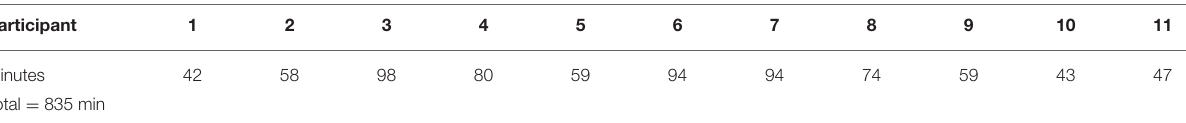
TABLE 3 | Duration of the interviews in